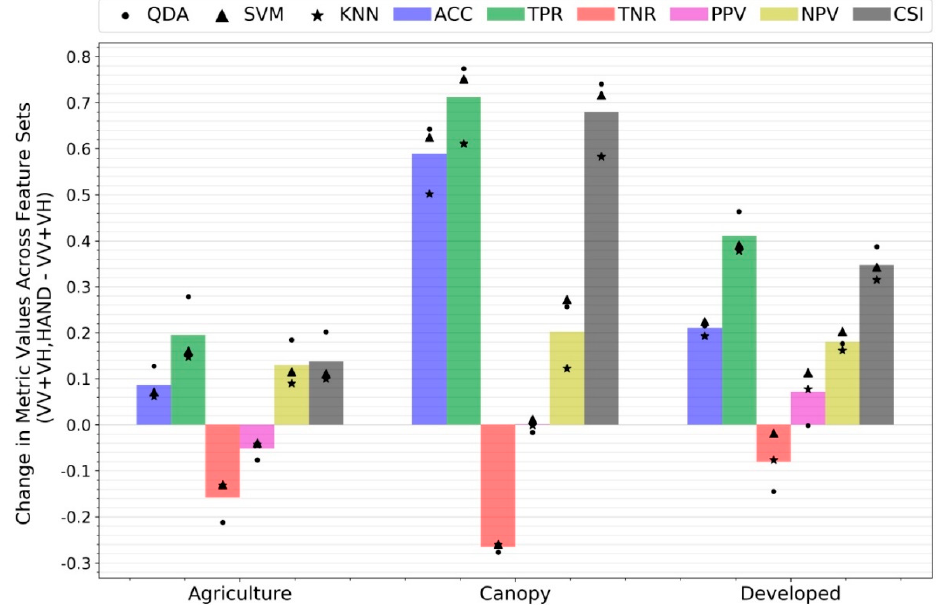
Figure 8. Changes in metrics across feature sets (VV, VH, and HAND minus VV and VH) for the three land cover groups listed by model and the average of the three models.